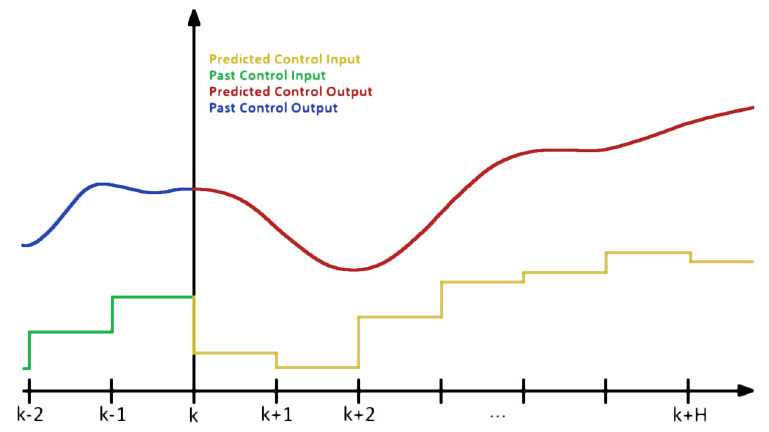
Figure 1. MPC scheme.